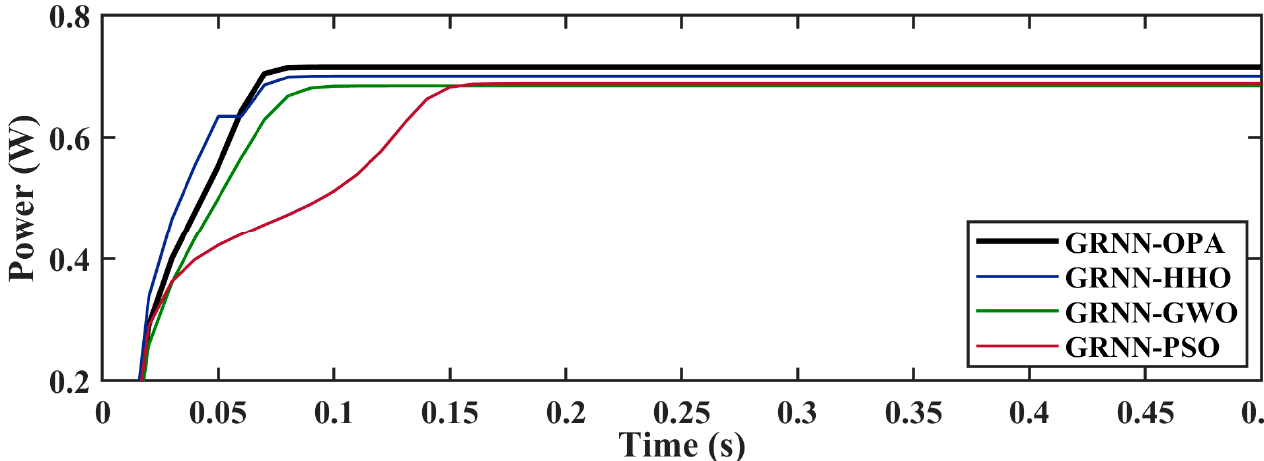
Table 1. Comparison of results for case